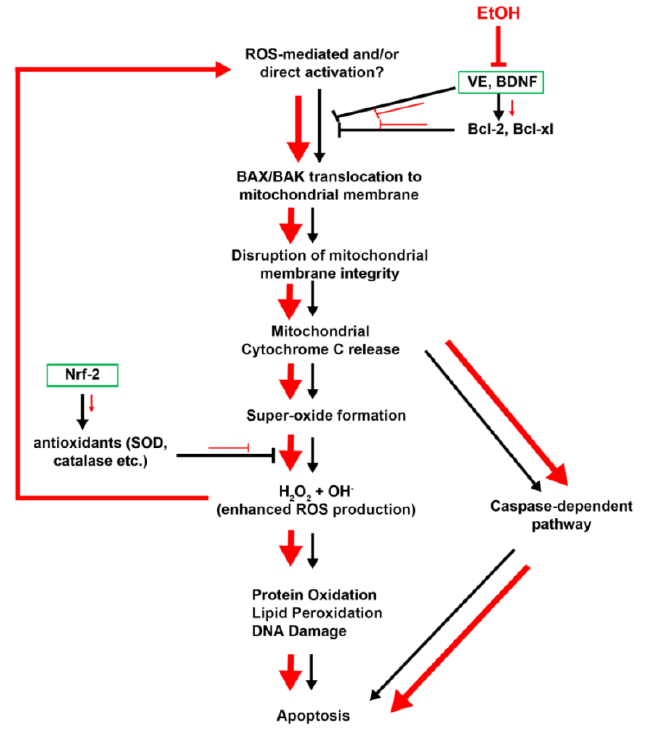
Figure 4. Proposed mechanism for ethanol-induced oxidative stress-mediated cell death. Ethanol can act as an oxidant by inducing the production of reactive oxidative species (ROS) during ethanol degradation. ROS can induce translocation of pro-apoptotic proteins, BAX/BAK to the mitochondrial membrane leading to disruption of membrane integrity. The resulting cytochrome c release induces caspase cascade, leading to apoptosis. Cytochrome c release also causes increased superoxide formation and enhanced ROS production. This leads to protein oxidation, lipid peroxidation and DNA damage, which can enhance apoptosis induction pathways. Vitamin E and neurotrophic factors such as BDNF and NT3 are known to inhibit BAX/BAK translocation and apoptosis. Anti- apoptotic proteins such as Bcl-2 and Bcl-xl are also affected by to reduced vitamin E (VE) and BDNF. Ethanol reduces vitamin E and neurotrophic factors, which in turn affect Bcl-2 and Bcl-xl. Together, ethanol promotes BAX/BAK translocation to mitochondrial membrane, leading to apoptosis. Key genes like Nrf-2 regulate antioxidant enzymes, including superoxide dismutase and catalase. This is reduced in ethanol-treated cells. Black lines/arrows indicate normal pathway for cell death, and red lines/arrows indicate ethanol- induced changes, increase or decrease. Green boxes indicate therapeutic targets that have been tested for rescue of oxidative-stress mediated cell